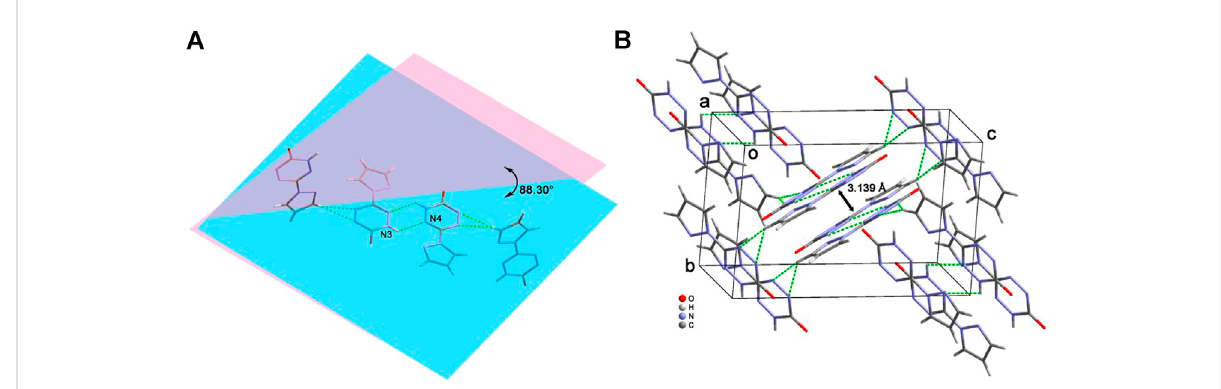
The “ head-to-head ” connecting mode of 6 (A) and its packing structure (B) .